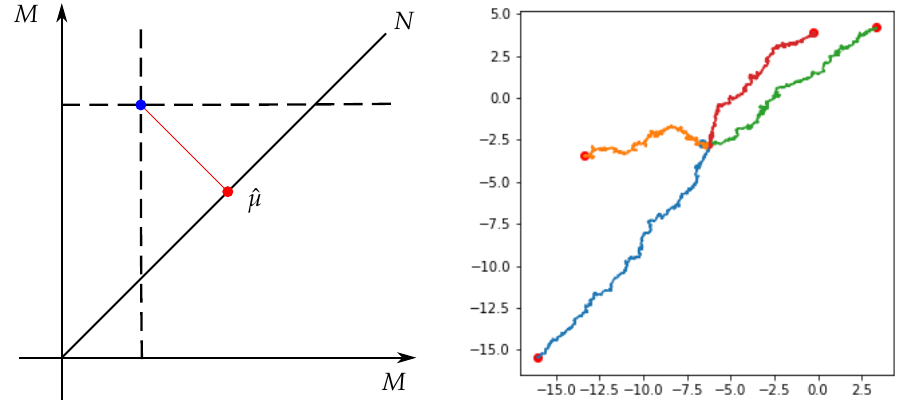
Figure 1. ( left ) The mean estimator viewed as a projection onto the diagonal of a product mani- fold. Given a set x 1 , . . . , x n ∈ M , the tuple ( x 1 , . . . , x n ) (blue dot) belongs to the product manifold M × · · · × M . The mean estimator ˆ µ can be identified with the projection of ( x 1 , . . . , x n ) onto the diagonal N (red dot). ( right ) Diffusion mean estimator in R 2 using Brownian bridges conditioned on the diagonal. Here a Brownian bridge X t = ( X 1, t , . . . , X 4, t ) in R 8 is conditioned on hitting the diagonal N ⊆ R 8 at time T > 0. The components X j each being two-dimensional processes are shown in the